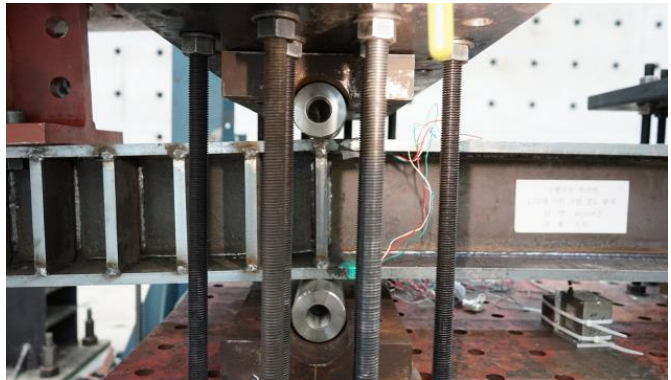
Figure 14. Boundary Condition. Table 4. Dimension of Sections and Parameters.